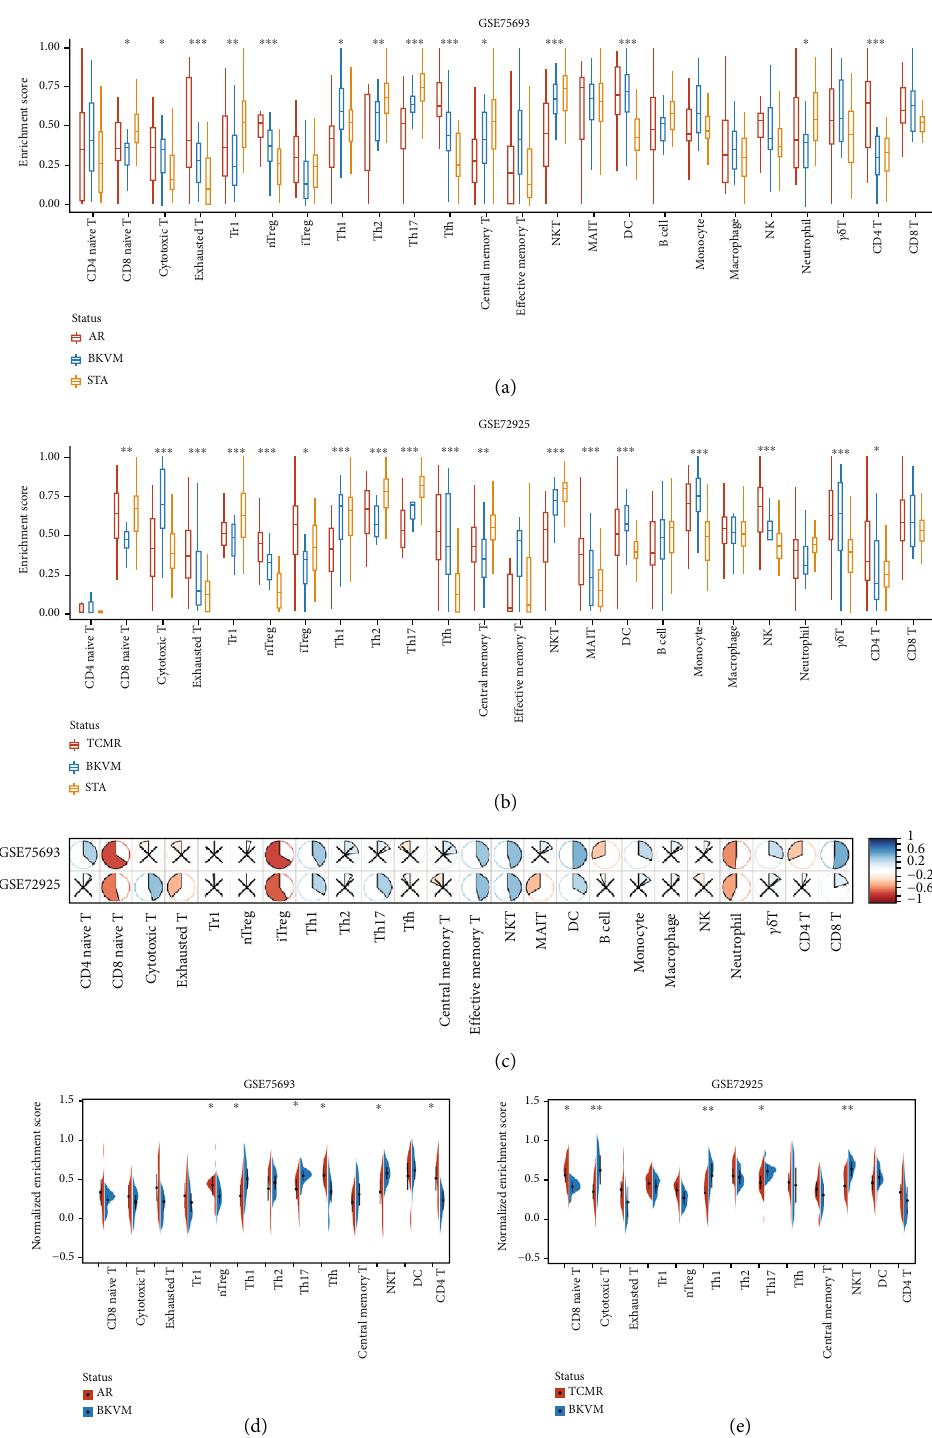
Figure 6: Estimation and comparison of immune cell in fi ltration. (a and b) Box plots show amounts of various immune cells among BKVN, AR (TCMR), and STA samples in training and validation cohorts. (c) Correlation heat map between the expression levels of RBBP7 and immune cell in fi ltration in the training and validation cohorts. The pie graphs are fi lled in proportion to Spearman ’ s coe ffi cient values. Anticlockwise for negative correlations (in red), clockwise for positive correlations (in blue); the red crosses represent no statistically signi fi cant correlations ( P > 0 : 05 ). (d and e) Half-violin plots show normalized amounts of immune cells between BKVN and rejection samples in training and validation cohorts. Immune cells with signi fi cantly di ff erent in fi ltration among three types of samples were incorporated. ∗ P < 0 : 05 ; ∗∗ P < 0 : 01 ; ∗∗∗ P < 0 : 001